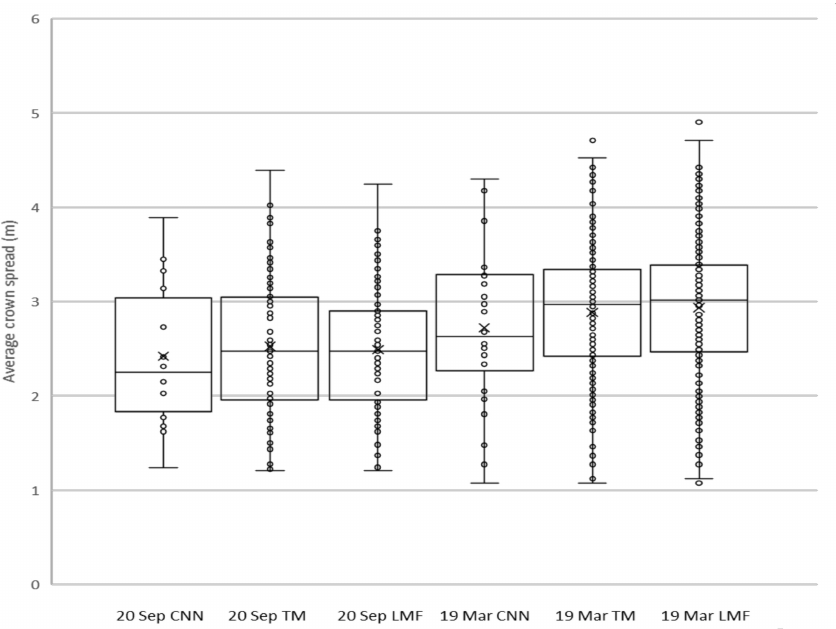
Figure 10. Box plot of average crown spread based on all false negative detections of the convolution neural network (CNN), template matching (TM), and local maximum filter (LMF) approaches from the 20 September and 19 March orthomosaics. A point plot of each plant’s average crown spread is represented by circles for each